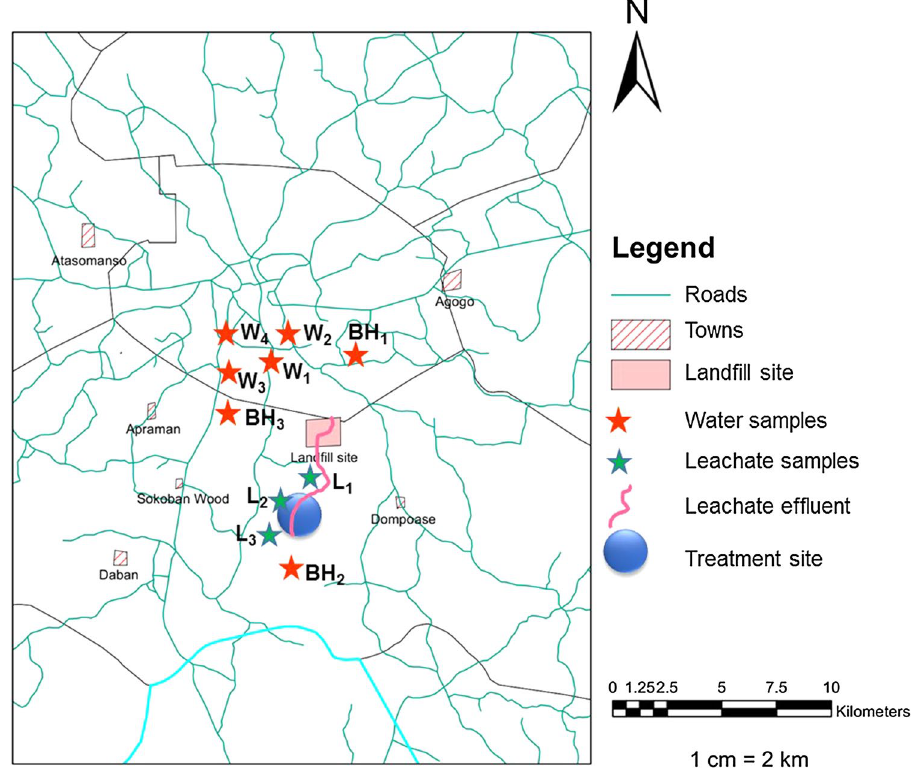
Fig. 1 Study area with